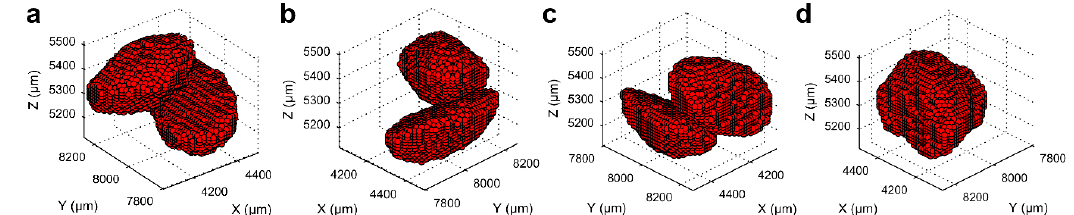
Figure 5. Manual inspection of each particle or group of particles in four different views with automatic and interactive MATLAB program. ( a ) Azimuth = − 37.5°, elevation = 30°; ( b ) azimuth = 45°, elevation = 30°; ( c ) azimuth = 135°, elevation = 30°; and ( d ) azimuth = 225°, elevation = 30°.